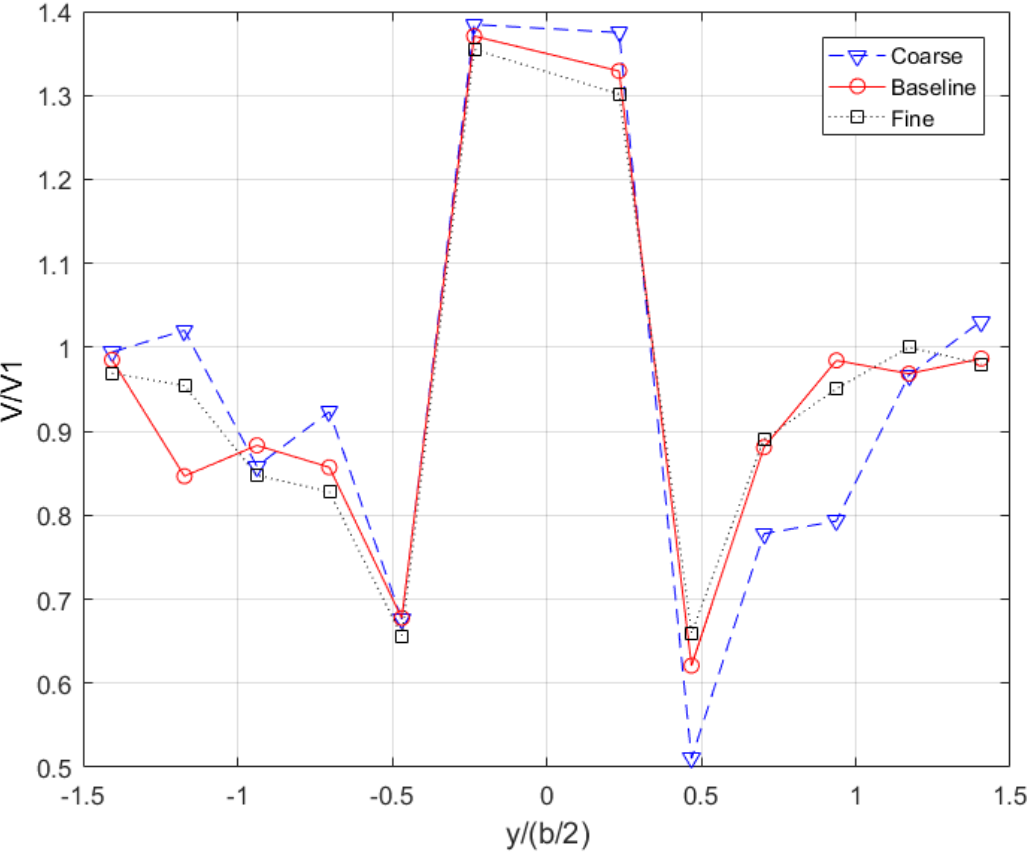
Figure 9. Comparison of the local speed of a monitor line for different